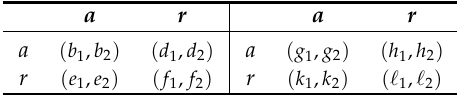
Table 9. Utilities for markets G 1 and G 2 .